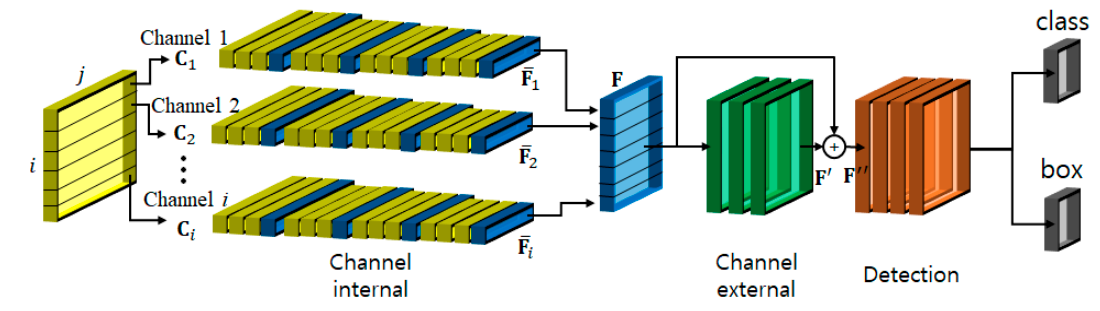
Figure 3. The structure of the proposed network.